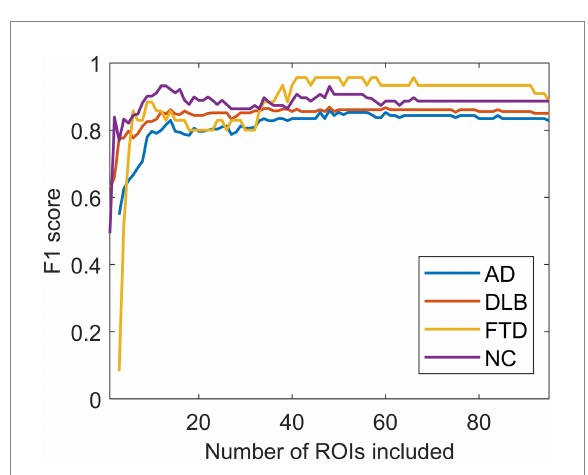
FIGURE 7 The effect of the number of regions of interest included on the F1 scores. F1 scores reached their maximal values after including the 40 most important regions of interest (ROIs). AD, dementia due to Alzheimer’s disease; DLB, dementia with Lewy bodies; FTD, frontotemporal dementia; NC, normal controls.